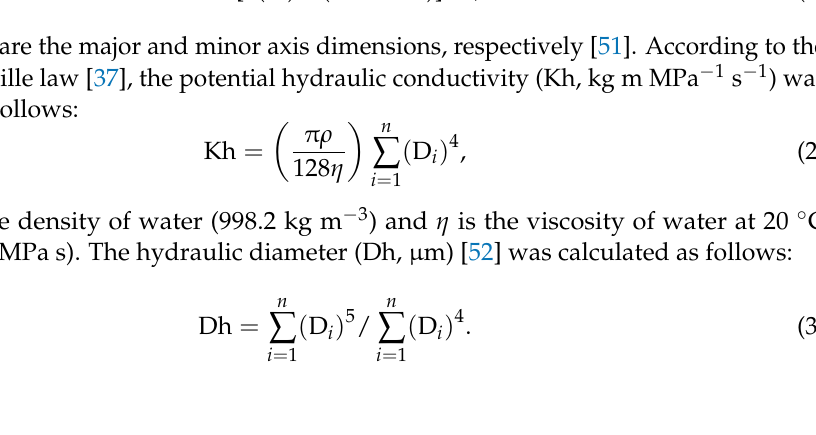
Table 1. Site characteristics of non ‐ native and native herbaceous species in arid and semiarid areas of China.